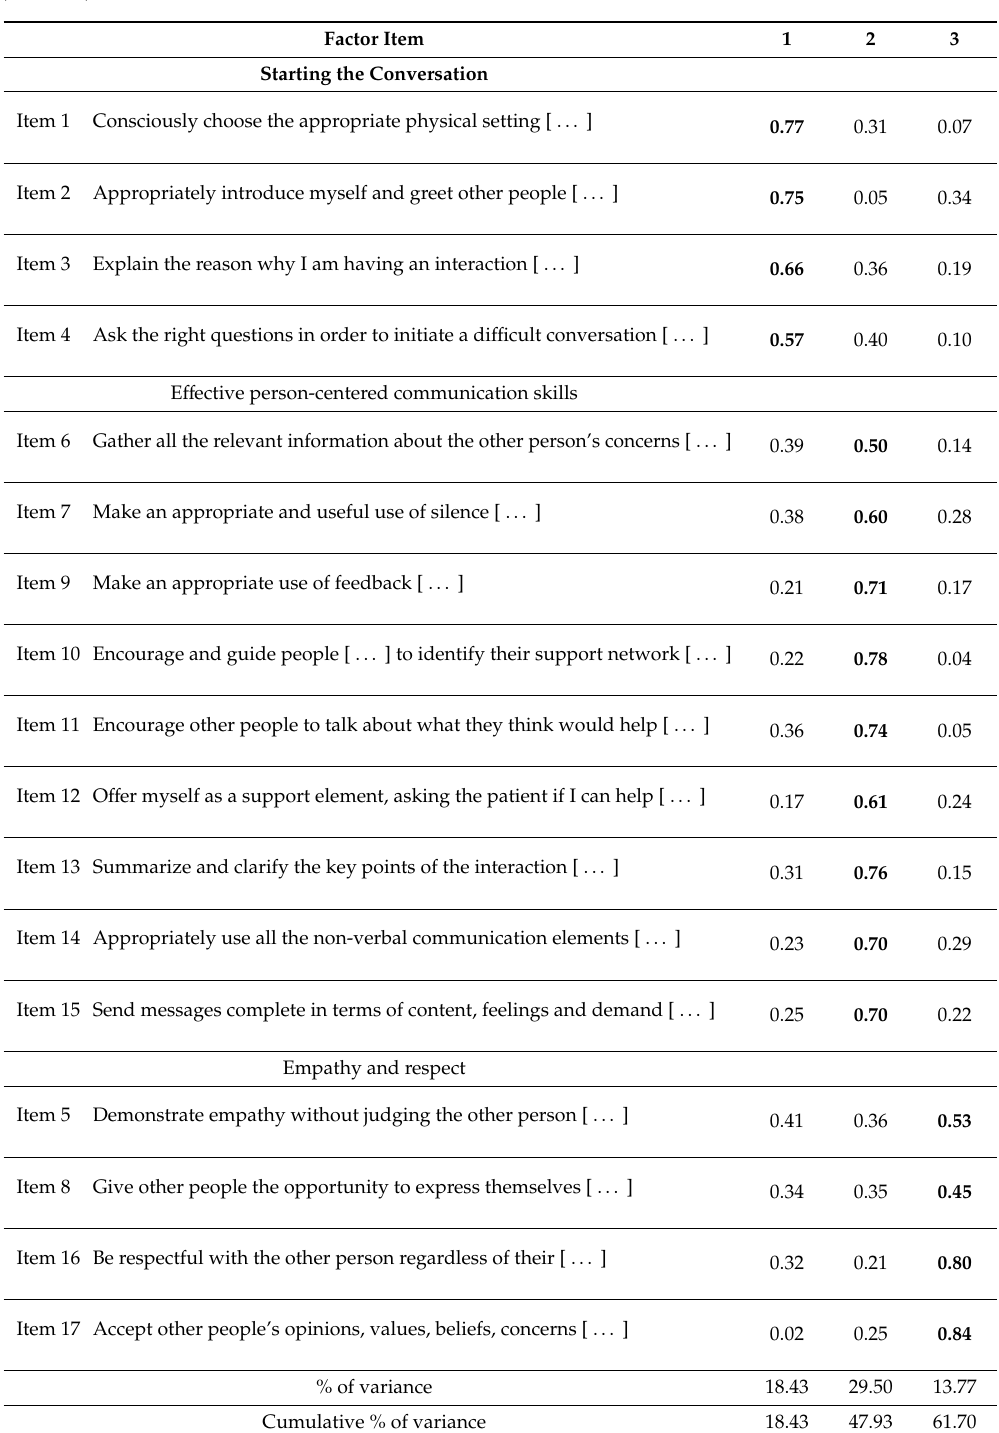
Table 3. Factor loadings and total variance explained from the rotated factor structure of the PCC-SES ( N = 305). Factor Item 1 2 3 Starting the